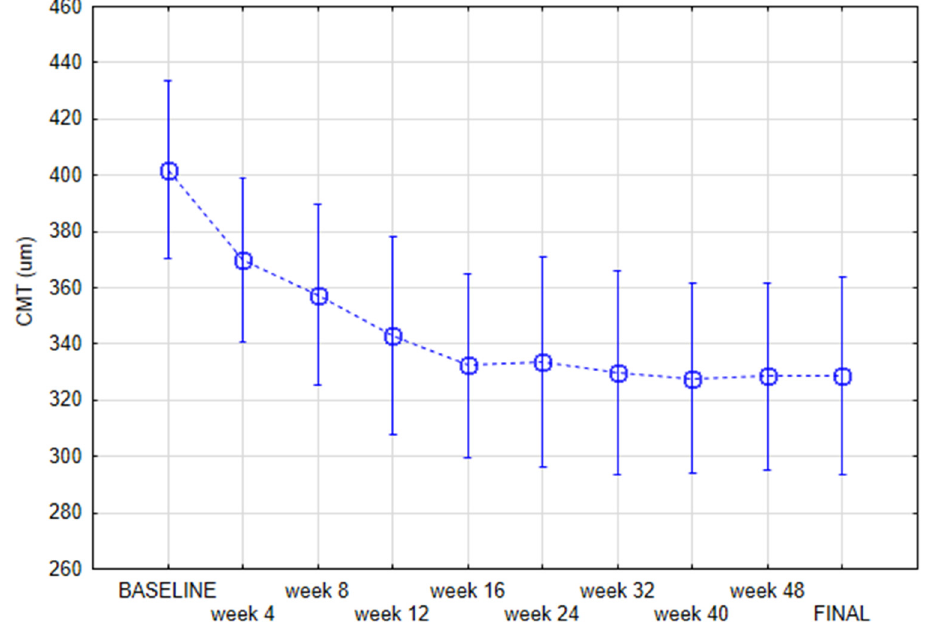
Figure 1. Central macular thickness (CMT) during the case of the study measured with repeated measures ANOVA current effect: F(9, 225 = 9.7280, p < 0.001). Anti-VEGF therapy resulted in statistically significant difference in the mean ETDRS scores from 65.18 ± 8.21 at baseline to 72.63 ± 7.43 letters ( p < 0.001) (Figure 2).